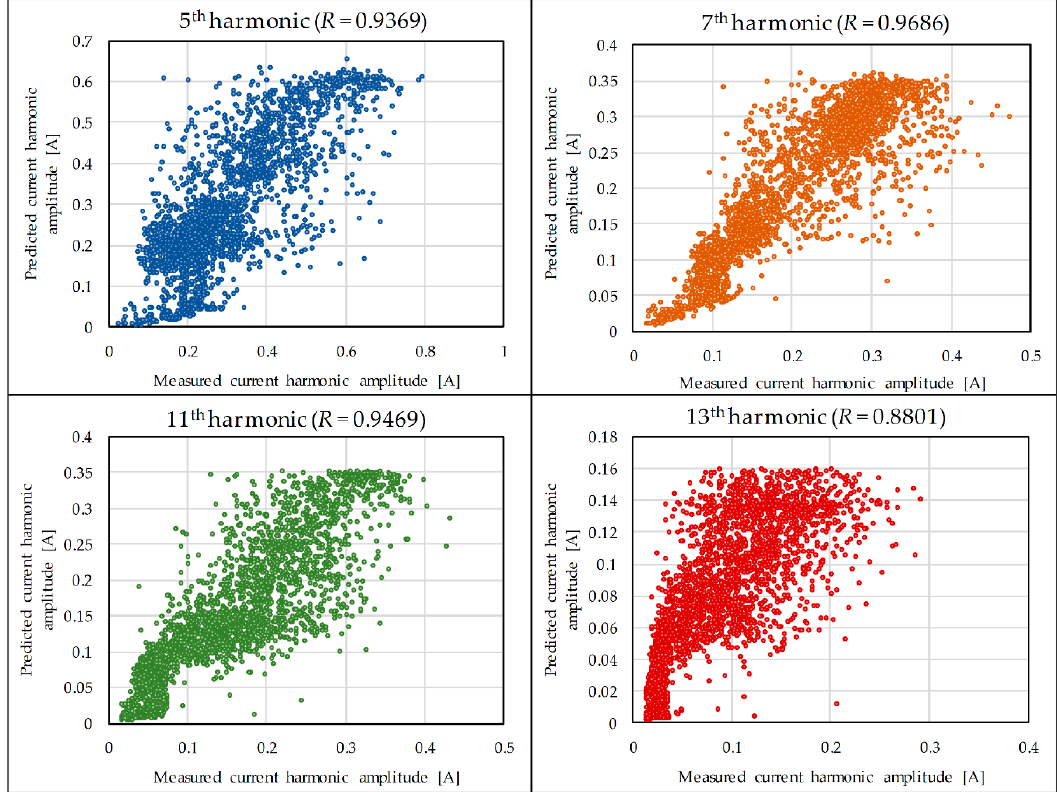
Figure 15. Scatterplots of the measured and predicted current harmonics by the MLPNN 6 model.